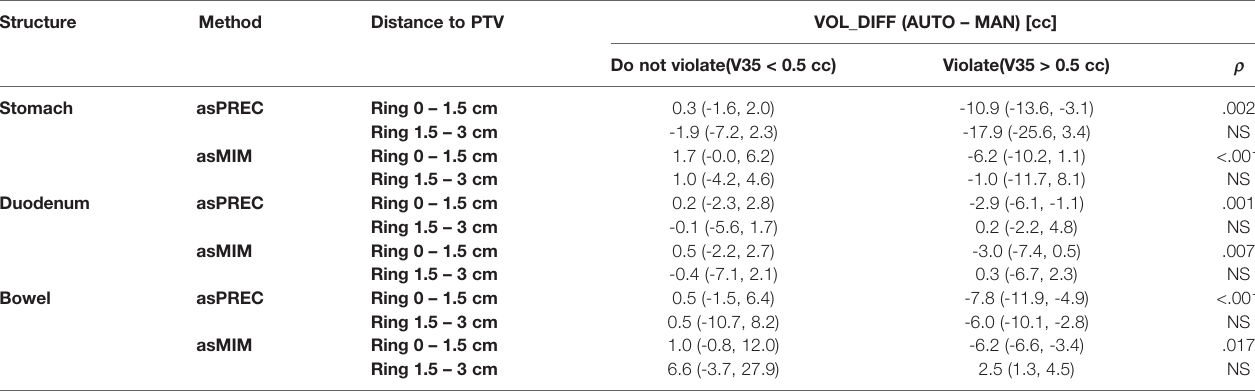
TABLE 4 | Median and interquartile range (Q1, Q3) of the volumetric difference of auto and manual contours in fractions violating and non-violating dose-constraints (V35Gy > 0.5cc) in the stomach, duodenum and bowel after replanning using precision (asPREC) and MIM (asMIM) autocontours. Structure